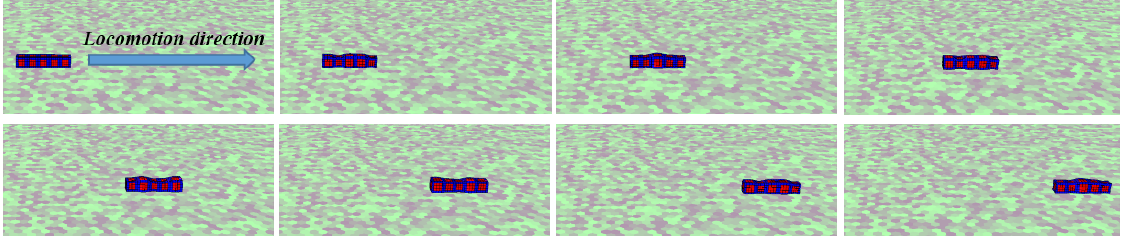
Figure 10. Locomotion Process of worm configuration in